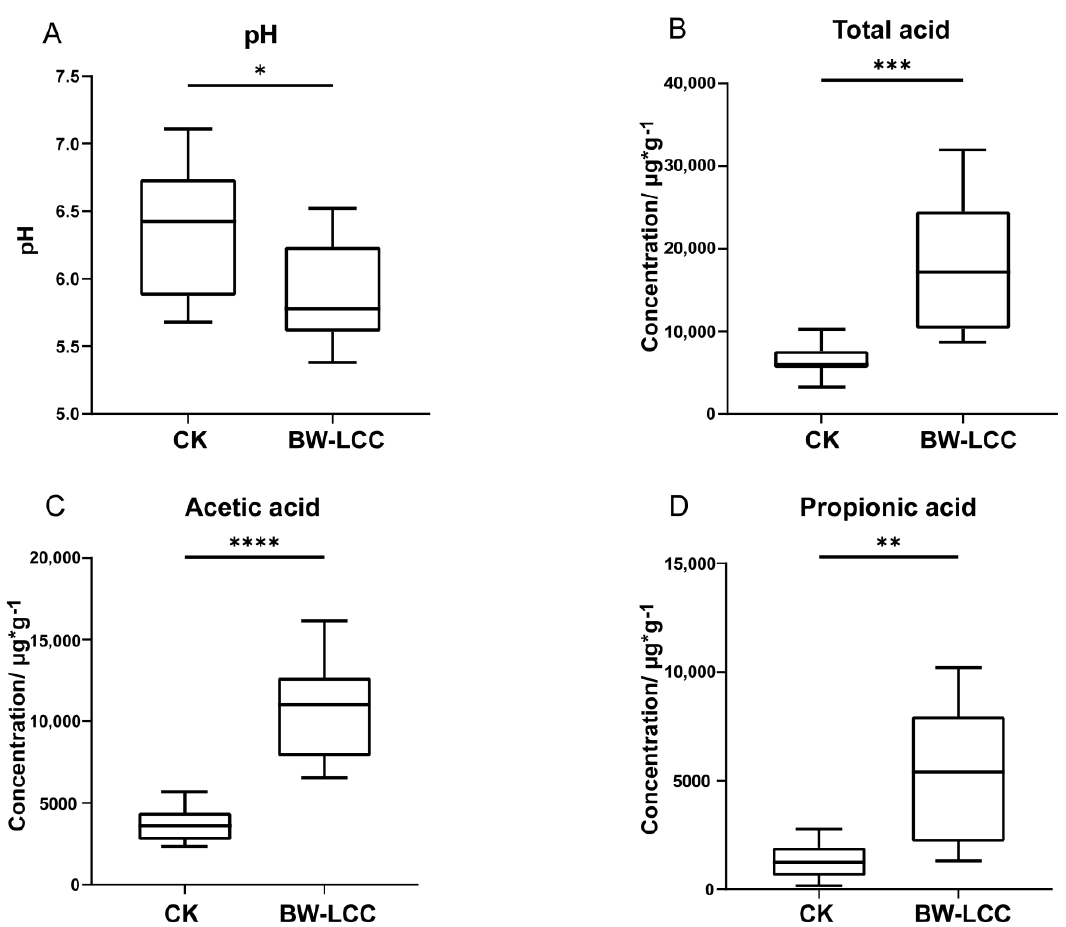
Figure 2. Changes of pH (A) and SCFA concentration compare with CK, including total acid (B), acetic acid (C) and propionic acid (D). *, P ＜ 0.05, **, P ＜ 0.01, ***, P ＜ 0.001, ****, P ＜ 0.0001.